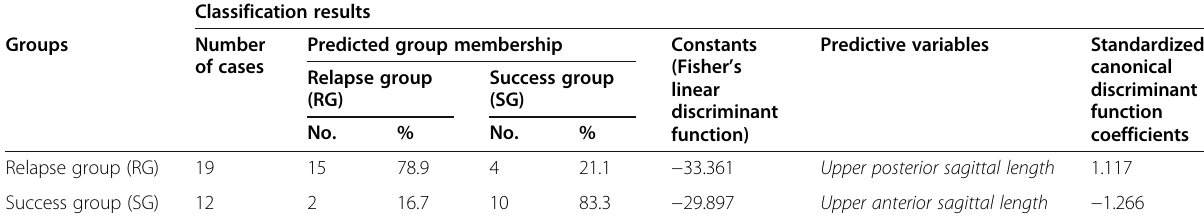
Table 8 Discriminant analysis of predictive success variables in class III early orthopedic treatment